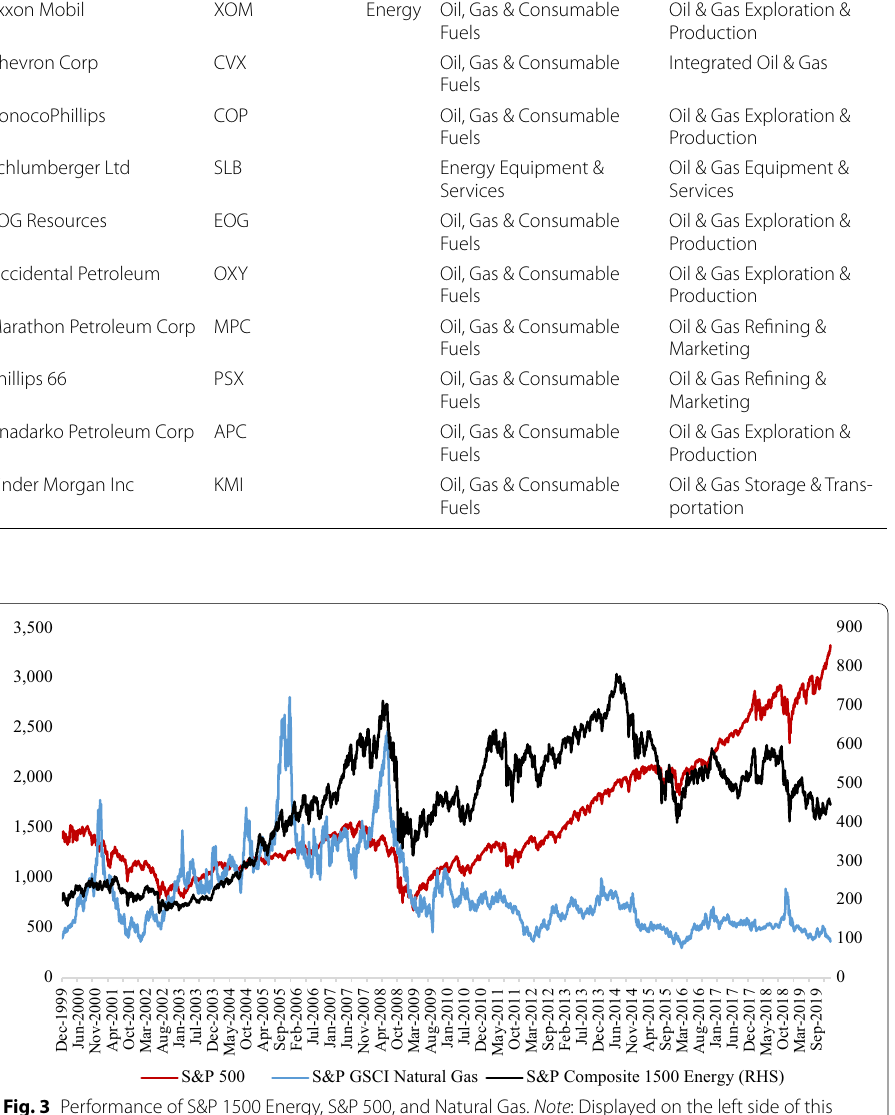
hand, the need for oil to produce electricity has fallen vastly due to the gradual with- drawal of highly depreciated petroleum assets, falling natural gas prices, availability of better gas-fired engines, and increased awareness of the climatic consequence of oil’s high sulfur content. On the other hand, despite the growth of associated gas in the U.S., the largest producer of natural gas, robust supply coming from shale players, like Utica/ Marcellus, has dampened the impact of the growth of natural gas prices (Mchich 2018). Post-2008, the S&P 500 performed comparatively better than the S&P 1500 composite